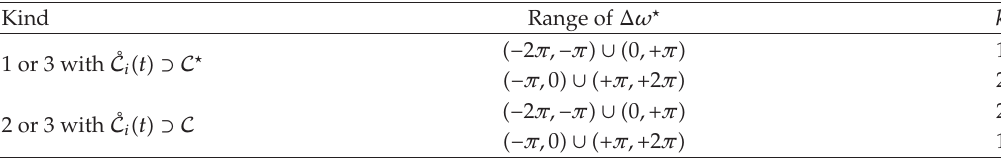
Table 3: Branches to be used for the square roots (cid:2) x − x (cid:6) the index k (cid:2) k (cid:7) 2 equal, k (cid:7) 1 di ff erent (cid:3) . They are specified in terms of the kind of the vortex with